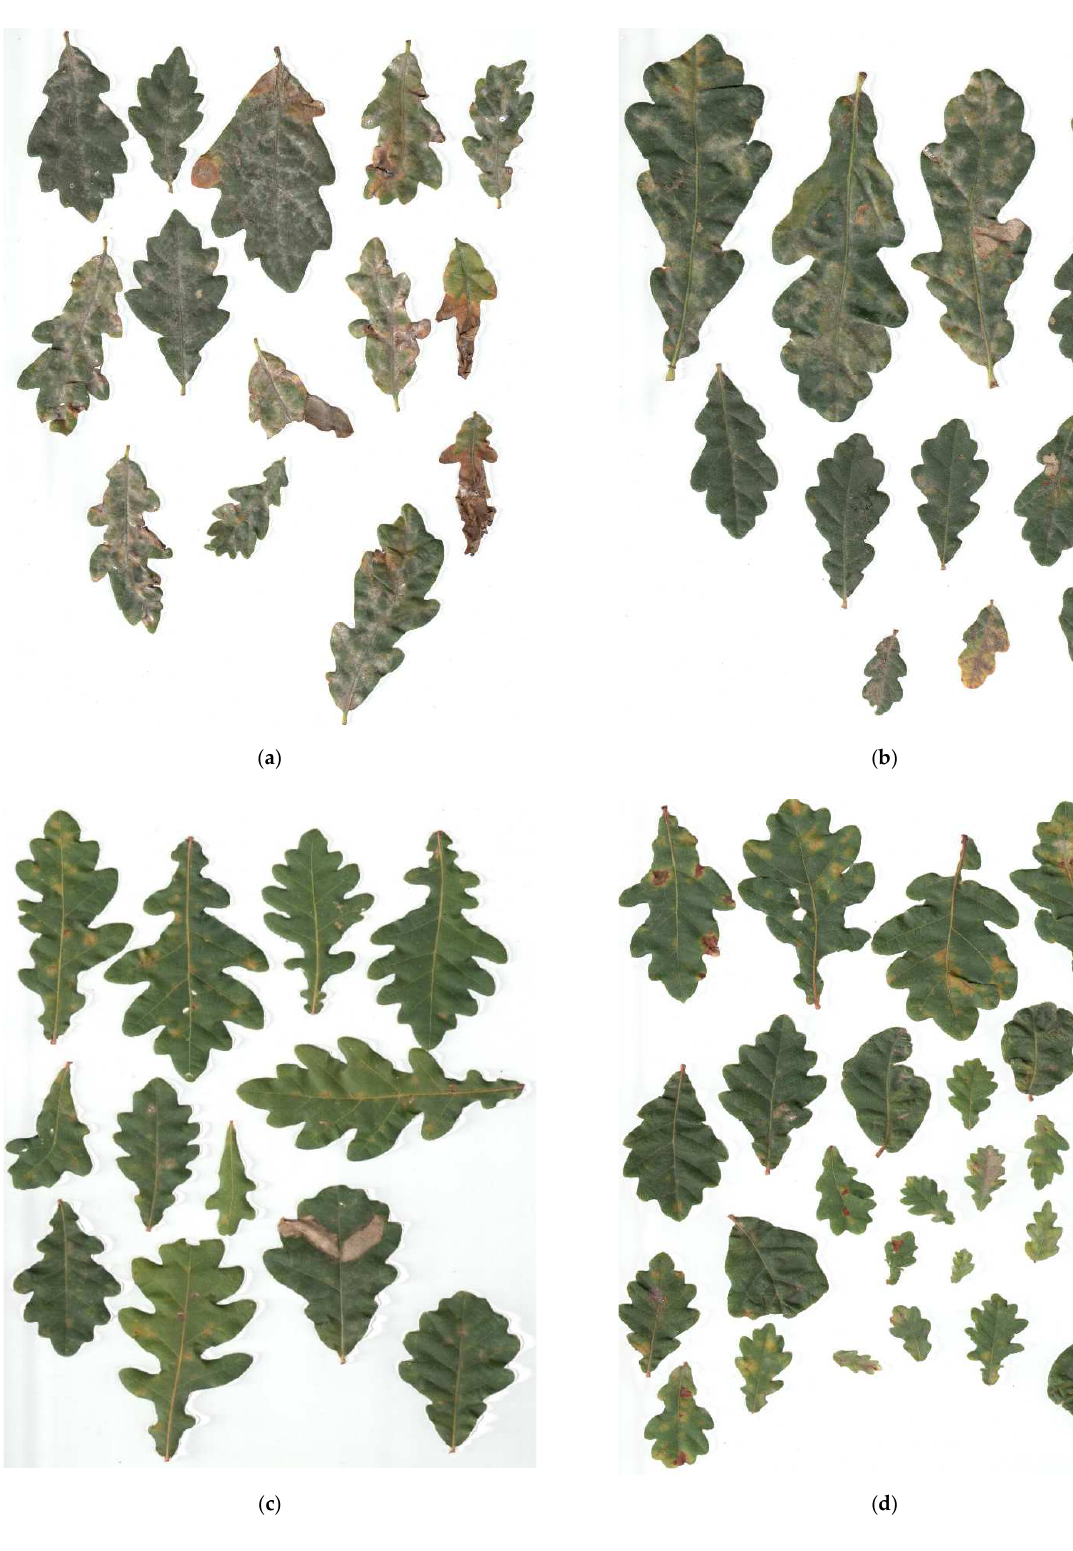
Figure 2 . An example of scans of oak leaves taken from plants growing in block A in 2015, infected with powdery mildew of oak, made with a scanner with a resolution of 300 dpi. ( a ) Full dose (100%), ( b ) 75% of the dose, ( c ) 50% of the dose, ( d ) 25% of the dose. The ratio of the dry root mass to dry seedling mass of the sessile oak (F = 6.85; p = 0.0004) differed significantly between the different irrigation rates in 2015, and also